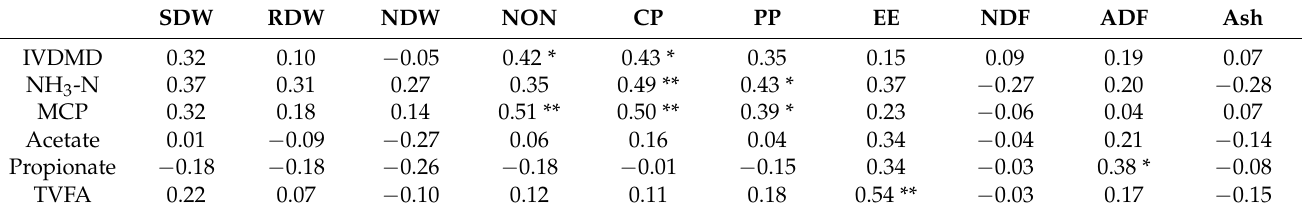
Table 8. Correlation analysis of production performance, nutritional composition, and in vitro fermentation.